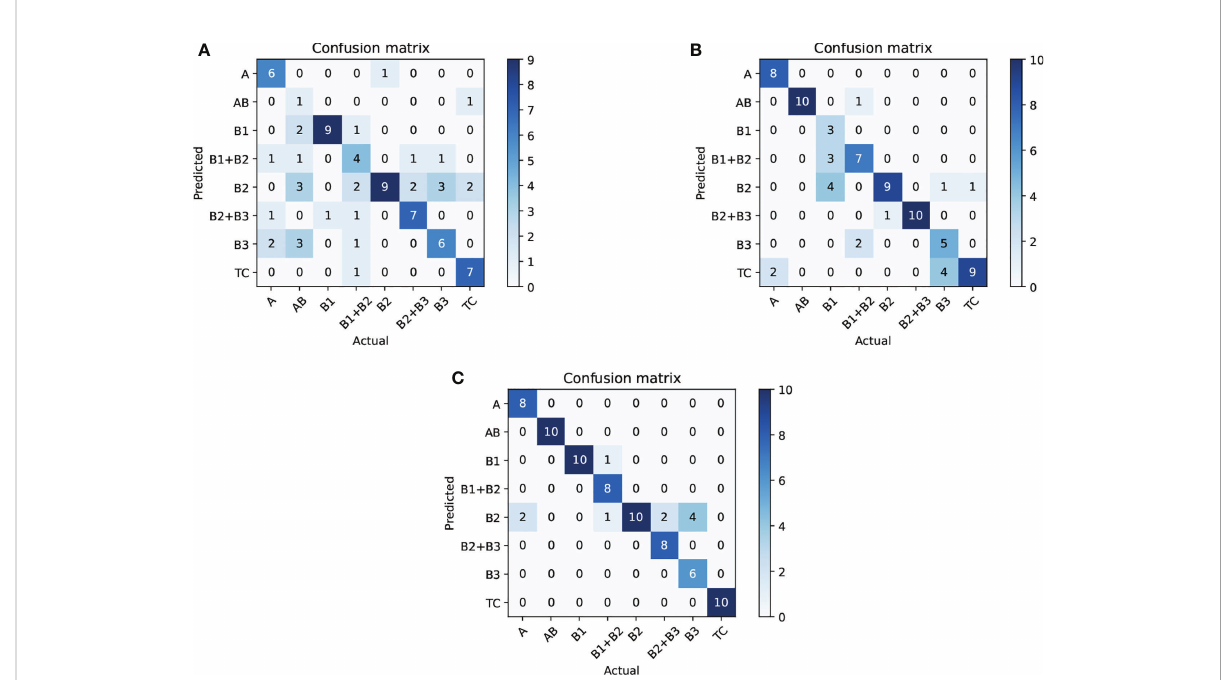
FIGURE 9 Ablation study (confusion matrix) for thymoma typing on the THW dataset; sub fi gures (A – C) are SPVT+WT, CAST w/o CAM+WT, and CAST+WT, where w/o represents without such